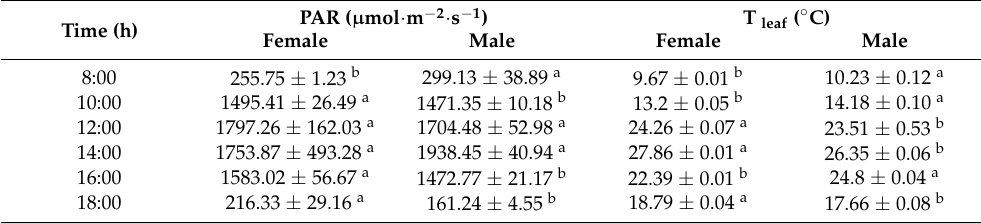
Figure 1. Daily variation of photosynthetic physiological indicators in male and female plants of H. tibetana . ( a ) Pn, net photosynthetic rate; ( b ) Tr, transpiration rate; ( c ) Gs, stomatal conductance; ( d ) WUE, water use efficiency; ( e ) Ci, intercellular CO 2 ; ( f ) Ls, stomatal limitation value—all measured in early August 2021 (8.1–8.3) 8:00–18:00 h. The day length was about 14 h. Table 2. Environmental photosynthetically active radiation (PAR) ( µ mol · m − 2 · s − 1 ) and leaf surface temperature (T leaf ) of photosynthetic diurnal variation of male and female H. tibetana , all measured in early August 2021 (8.1–8.3) 8:00–18:00 h. The day length was about 14 h. (a, b indicate that there is a significant difference in the mean from large to small).